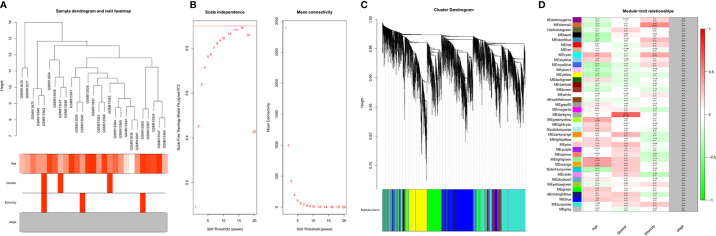

(A) Clustering dendrogram of samples with trait heatmap. (B) Analysis of network topology for various soft-thresholding powers. The left panel shows the scale-free fit index (y-axis) as a function of the soft-thresholding power (x-axis). The right panel displays the mean connectivity (degree, y-axis) as a function of the soft-thresholding power (x-axis). (C) Clustering dendrogram of genes, with dissimilarity based on topological overlap, together with assigned module colors. (D) Module-trait associations: Each row corresponds to a module eigengene and each column to a trait. Each cell contains the corresponding correlation and p-value. The table is color-coded by correlation according to the color legend. Distribution of average gene significance and errors in the modules associated with gender and ethnicity of cancer patient.